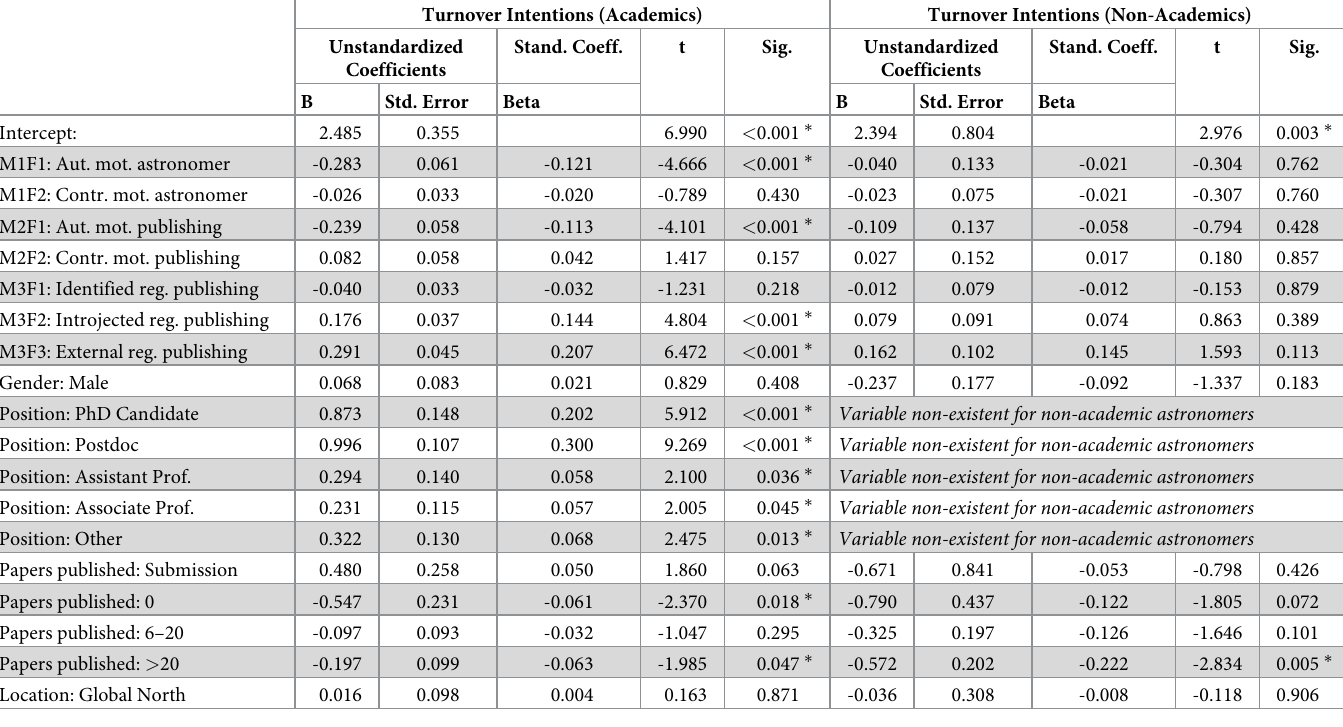
Table 4. Regression model of DV = Turnover intentions of astronomers who are primarily employed at an academic institution (N = 1147) versus at a non-aca- demic (N = 224) institution; regressed onto the seven motivational factors and the control variables. Turnover Intentions (Academics) Turnover Intentions (Non-Academics) Unstandardized Stand. Coeff. t Sig. Unstandardized Stand. Coefficients Coefficients